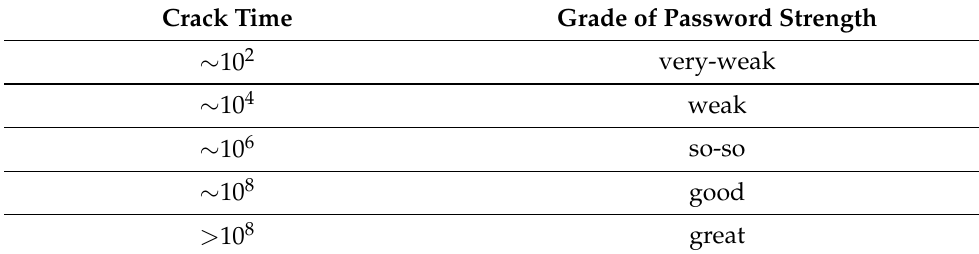
Table 2. Metering result calculation from the crack time (in